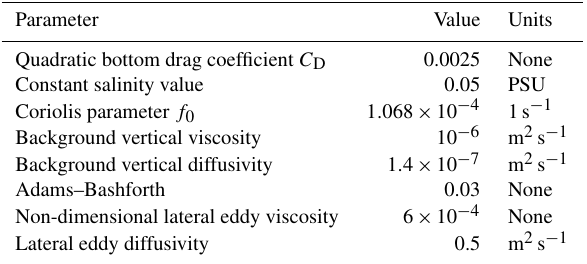
Table 1. Hydrodynamic model